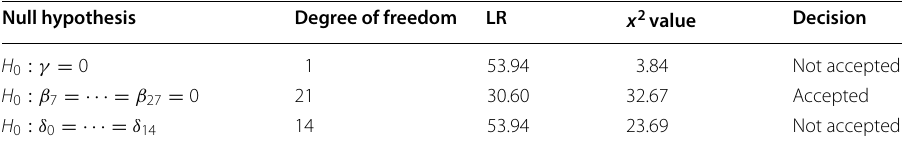
Table 1 Summary of tests of the assumption of stochastic frontier approach Source : Model output